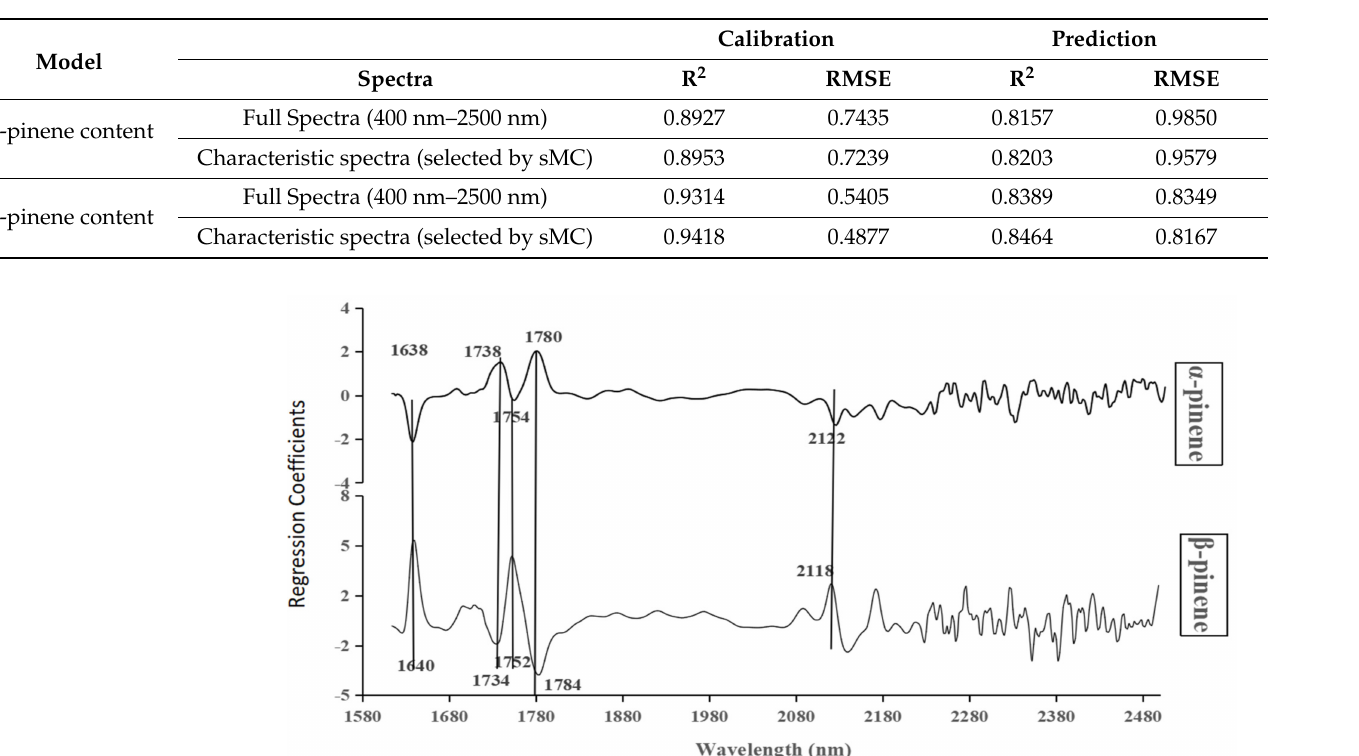
Table 2. The indicators of internal cross-validation, the correlation coefficient (R 2 ) and root mean square error (RMSE) for the calibration and prediction model of α - and β -pinene content based on full and characteristic spectra.